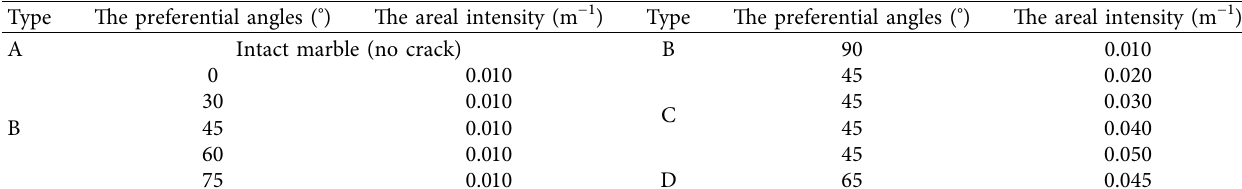
Table 2: Crack geometries of precracked specimens.